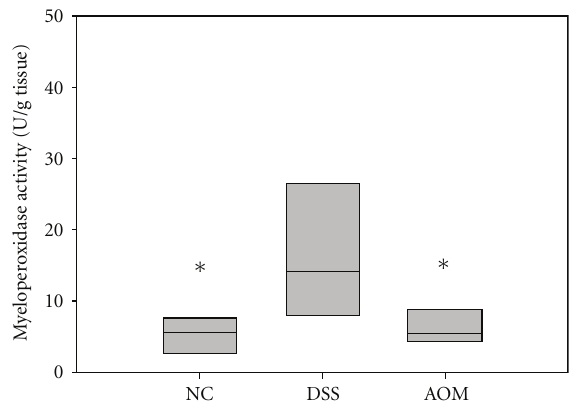
Figure 1: Myeloperoxidase activities (U/g tissue) in colonic tissue; ∗ denotes P < 0 . 05 compared to the DSS group.